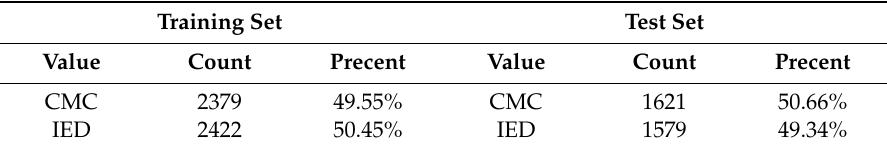
Table 7. Training set and test set.